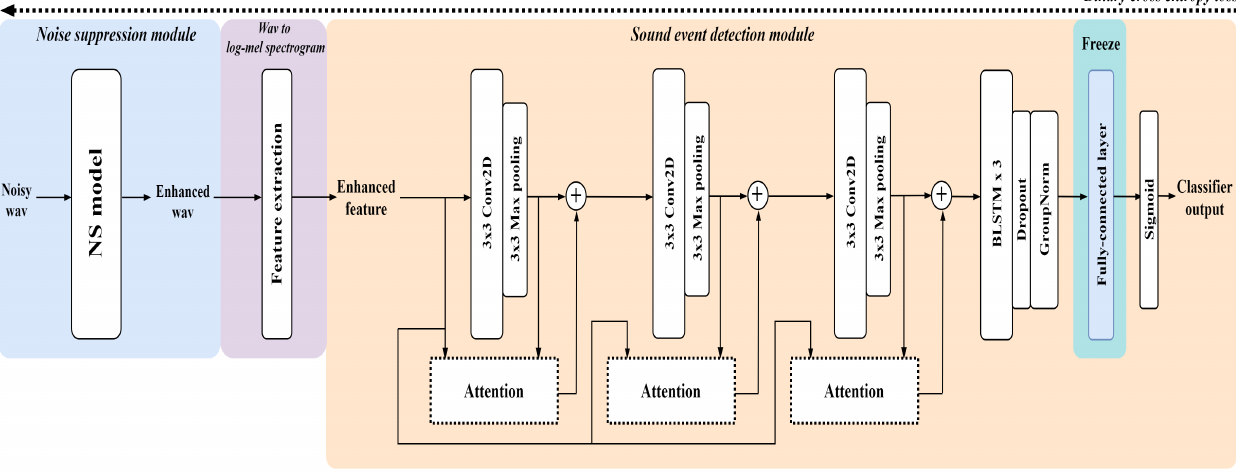
Figure 2. Overall procedure of attention-based joint training.